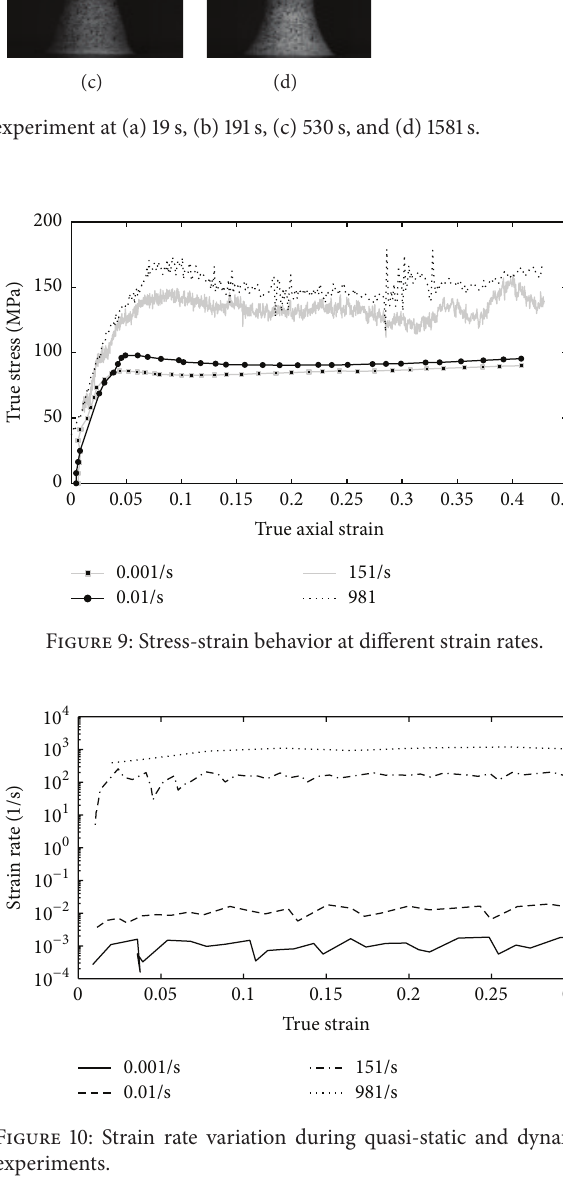
Figure 8: Average volume ratio and average cross-sectional area ratio in terms of the tensile axial strain.